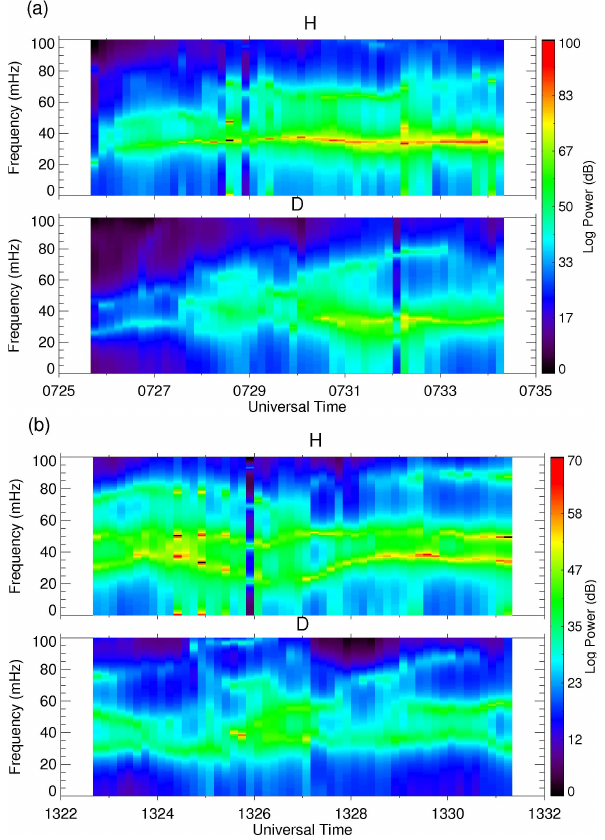
Fig. 4. MESA dynamic power spectra of the HER H- and D- components for (a) data plotted in Fig. 3a and (b) for data plotted in Fig. 3b.